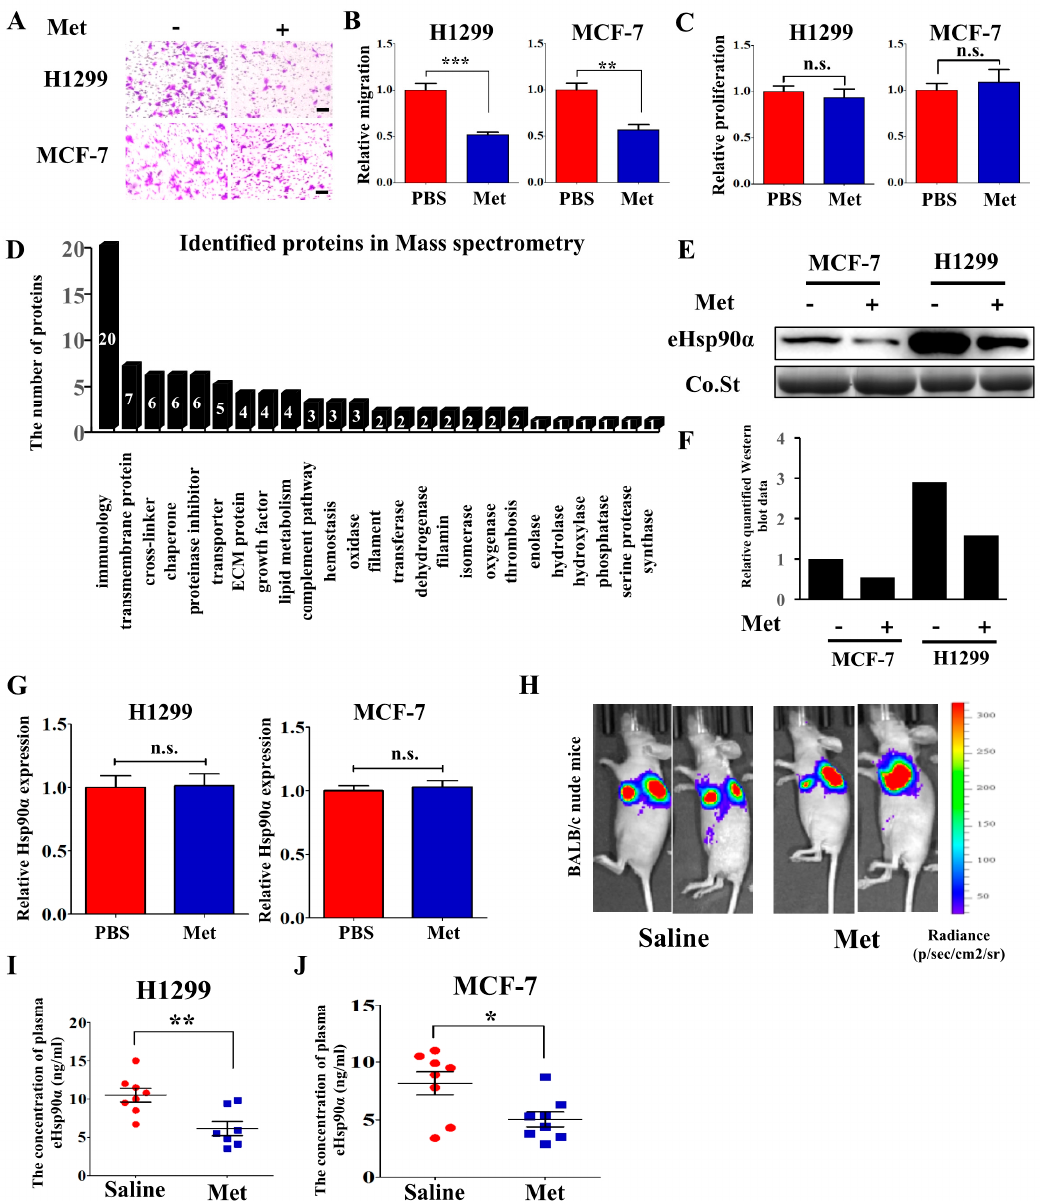
Figure 1. Metformin inhibits Hsp90 α secretion both in vitro and in vivo. ( A ) Representative images and ( B ) quantified results of H1299 and MCF-7 cells migration assay treated with PBS or metformin (200 µ M). Scale bar, 100 µ m. ** p < 0.01, *** p < 0.001. ( C ) The e ff ects of metformin (200 µ M) on H1299 and MCF-7 cells proliferation in vitro at 48 h. Cells were seeded into 96-well plates and cell proliferation was examined by CCK-8 assays. ( D ) Functional analysis of identified proteins in Mass spectrometry. ( E ) The conditioned medium (CM) of H1299 and MCF-7 cells was collected and concentrated, and then extracellular Hsp90 α (eHsp90 α ) was measured by Western blot. Co.St (Coomassie brilliant blue) was used as a control. ( F ) The quantified results of the Western blot. ( G ) The e ff ects of metformin (200 µ M) on the expression of Hsp90 α measured by qRT-PCR. (H-I) H1299 cells with luciferase activity were orthotopically injected into nude mice ( n = 7 or 8/group). Mice were treated once daily with saline or metformin (250 mg/kg) by oral gavage. ( H ) Representative bioluminescent (BLI) images were acquired. Heat-maps indicated the intensity of bioluminescence from low (blue) to high (red). ( I ) Plasma was collected and extracellular Hsp90 α was measured by ELISA assay. ( J ) MCF-7 cells were injected into nude mice ( n = 8/group) and extracellular Hsp90 α in plasma was measured by ELISA assay.